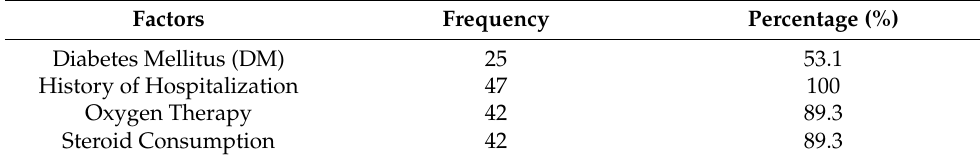
Table 1. Clinical characteristics of patients with confirmed mucormycosis.